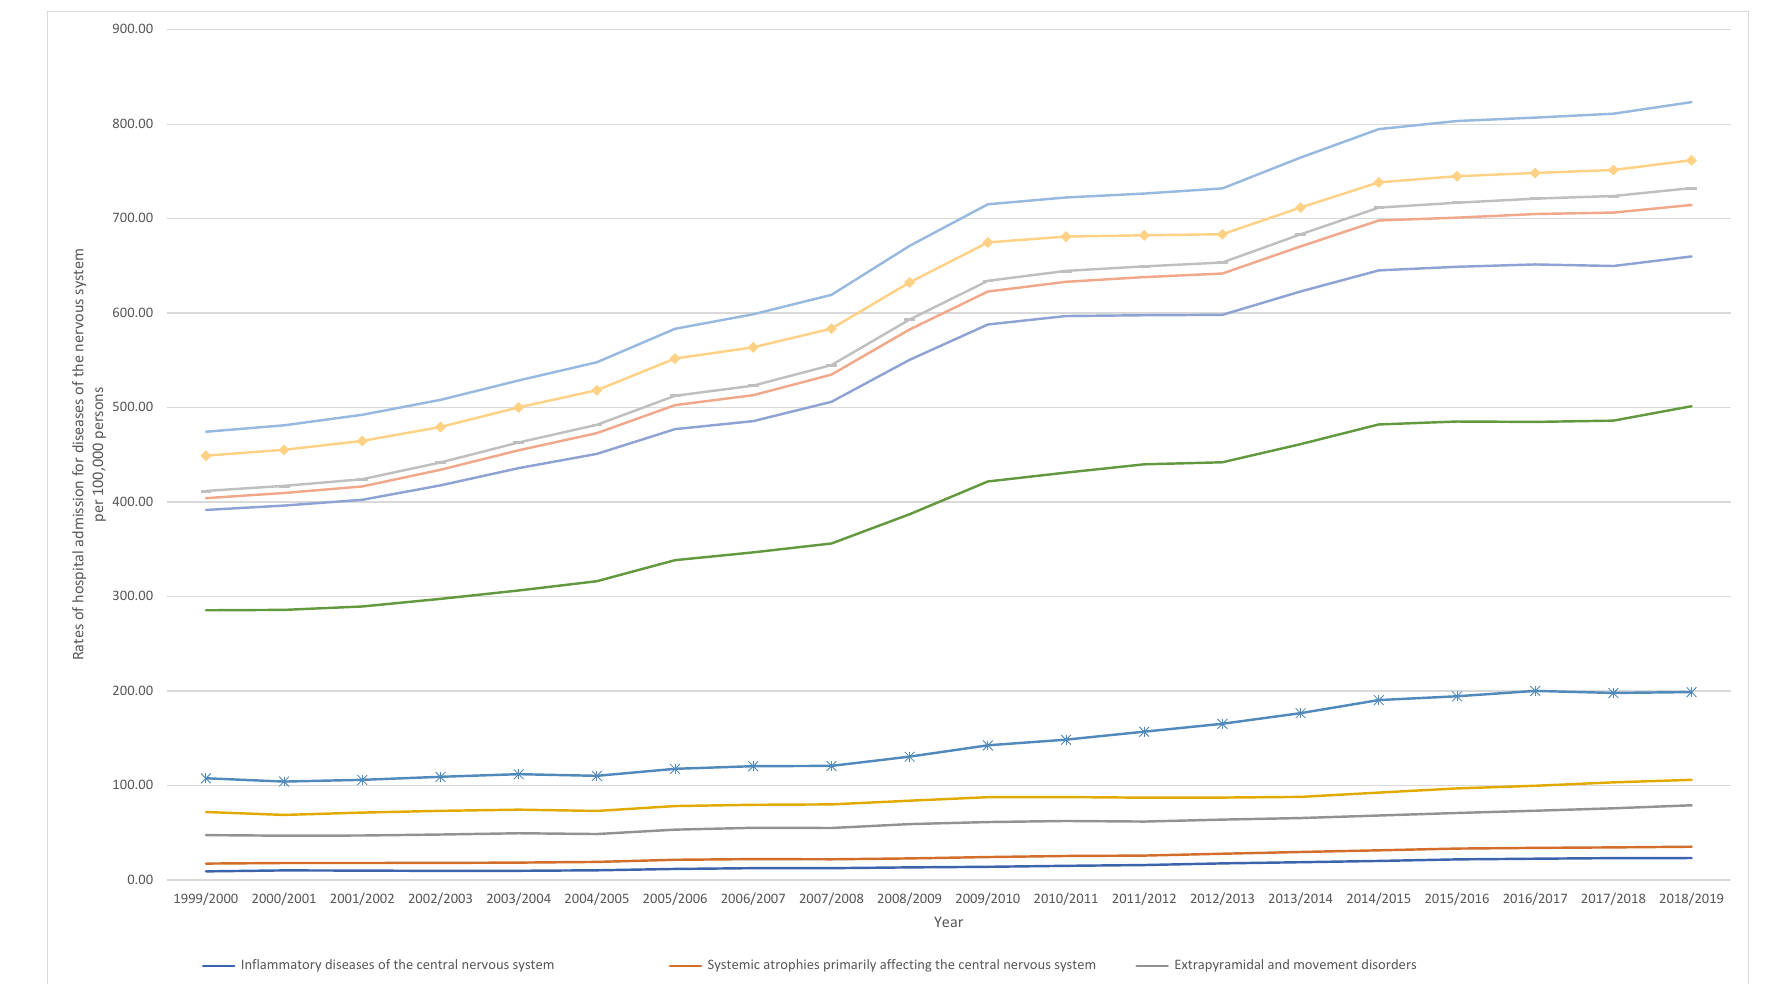
0.00100.00200.00 Figure 1. Rates of hospital admission for diseases of the nervous system in England and Wales stratified by type between 1999 and 2019.